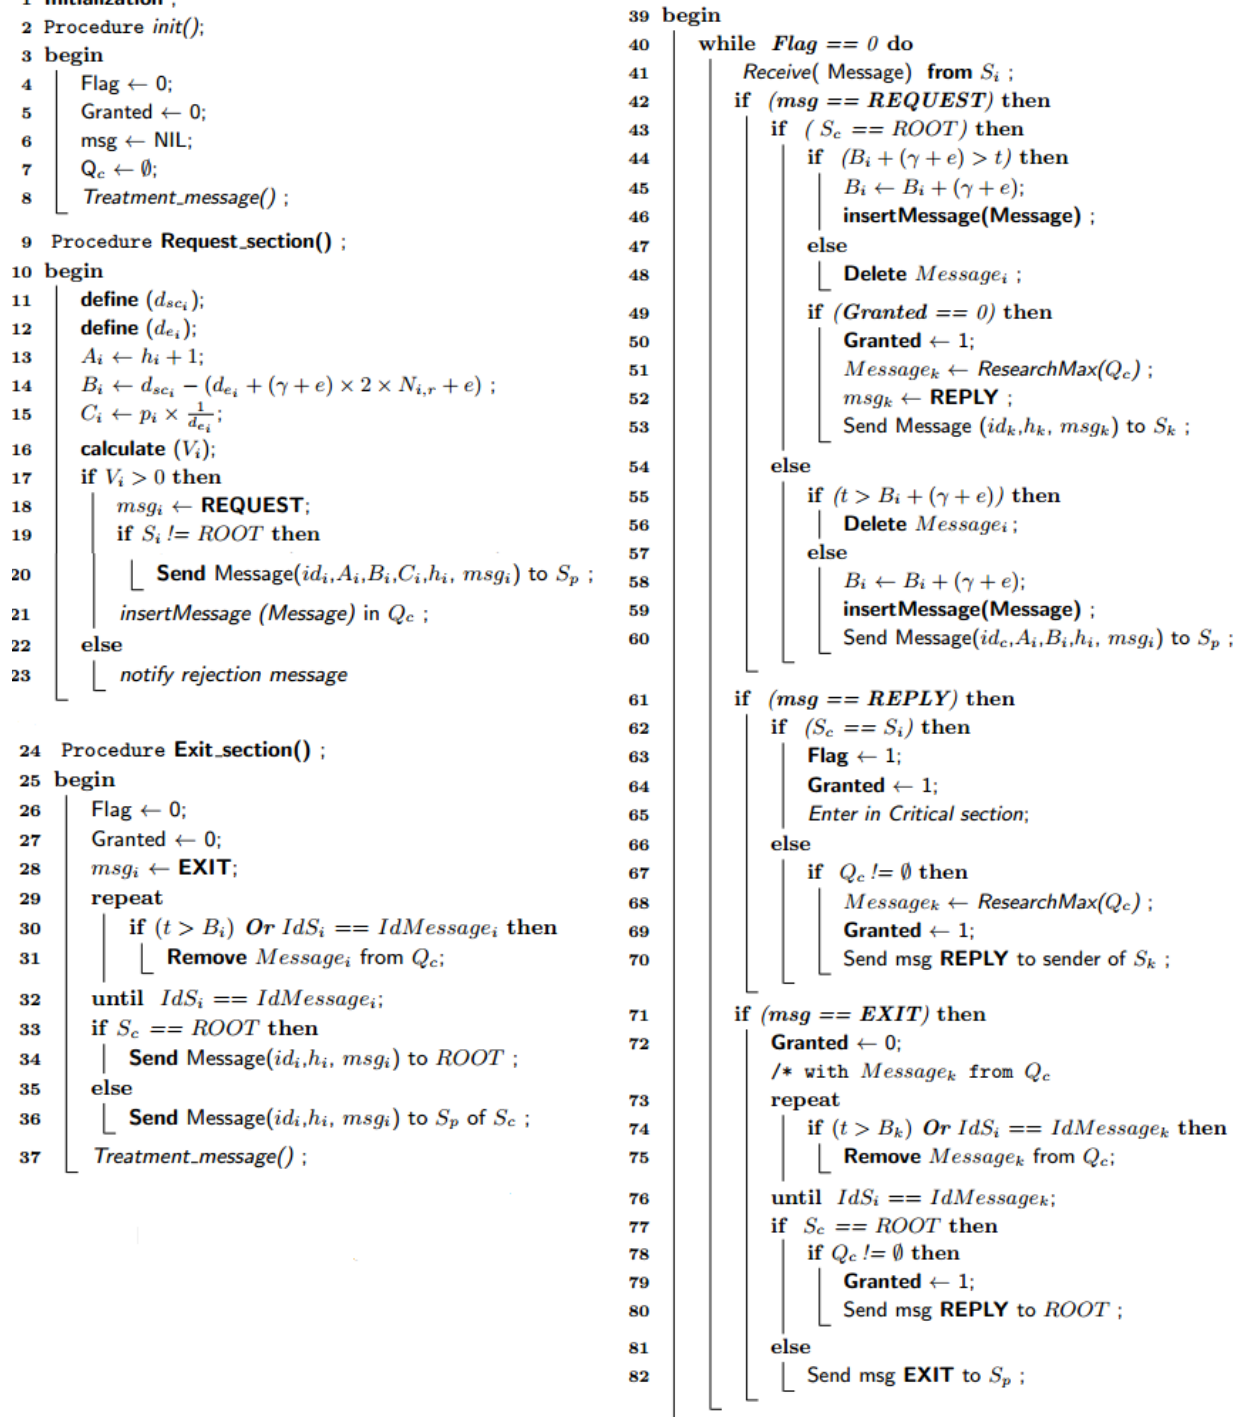
Figure 2 : The PBDMEAQoSα